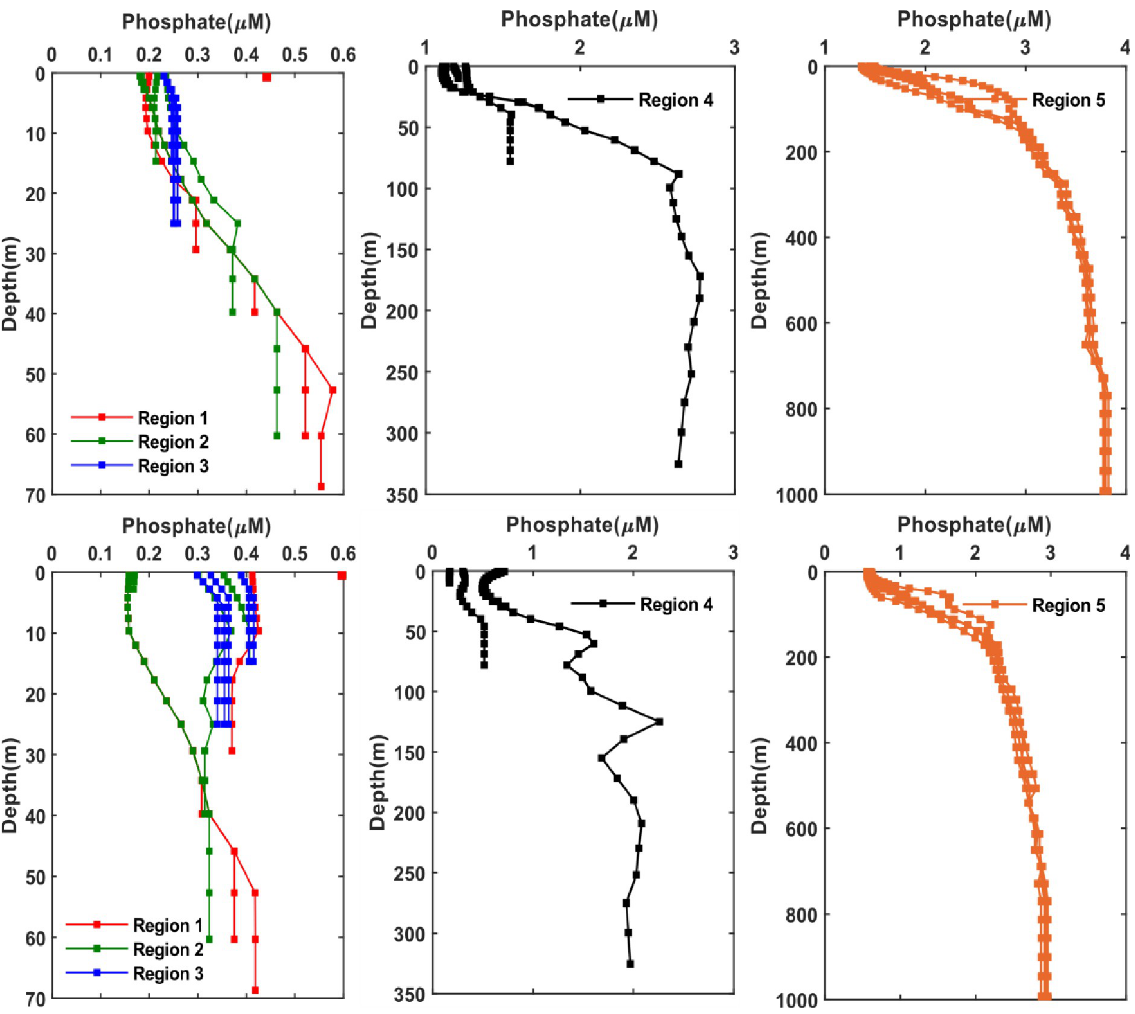
Fig 6. Seasonal phosphate profiles at different regions divided over the Arabian Gulf and Sea of Oman (as per Fig 1) extracted from the monthly climatology of the World Ocean Atlas data (WOA) for the year 2018. The WOA data are climatological data collected from the periods 1900–2017. Top: Summer season (June, July, August); bottom: Winter season (December, January, February). Left: Arabian Gulf, middle: Strait of Hormuz, right: Sea of